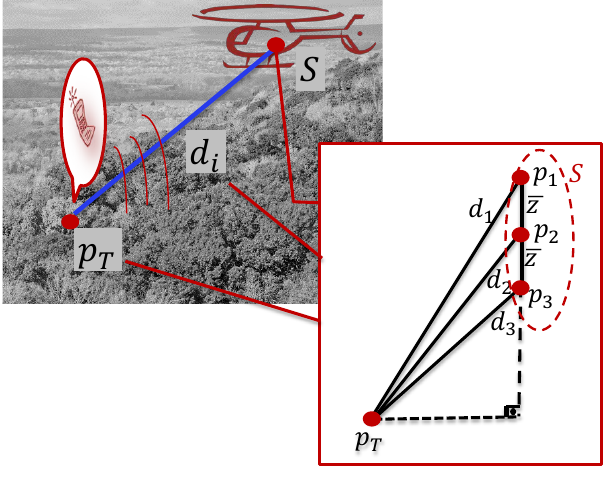
Figure 1. An illustration of the localization task setting and the proposed sensor array geometry, mobile sensor triplet unit